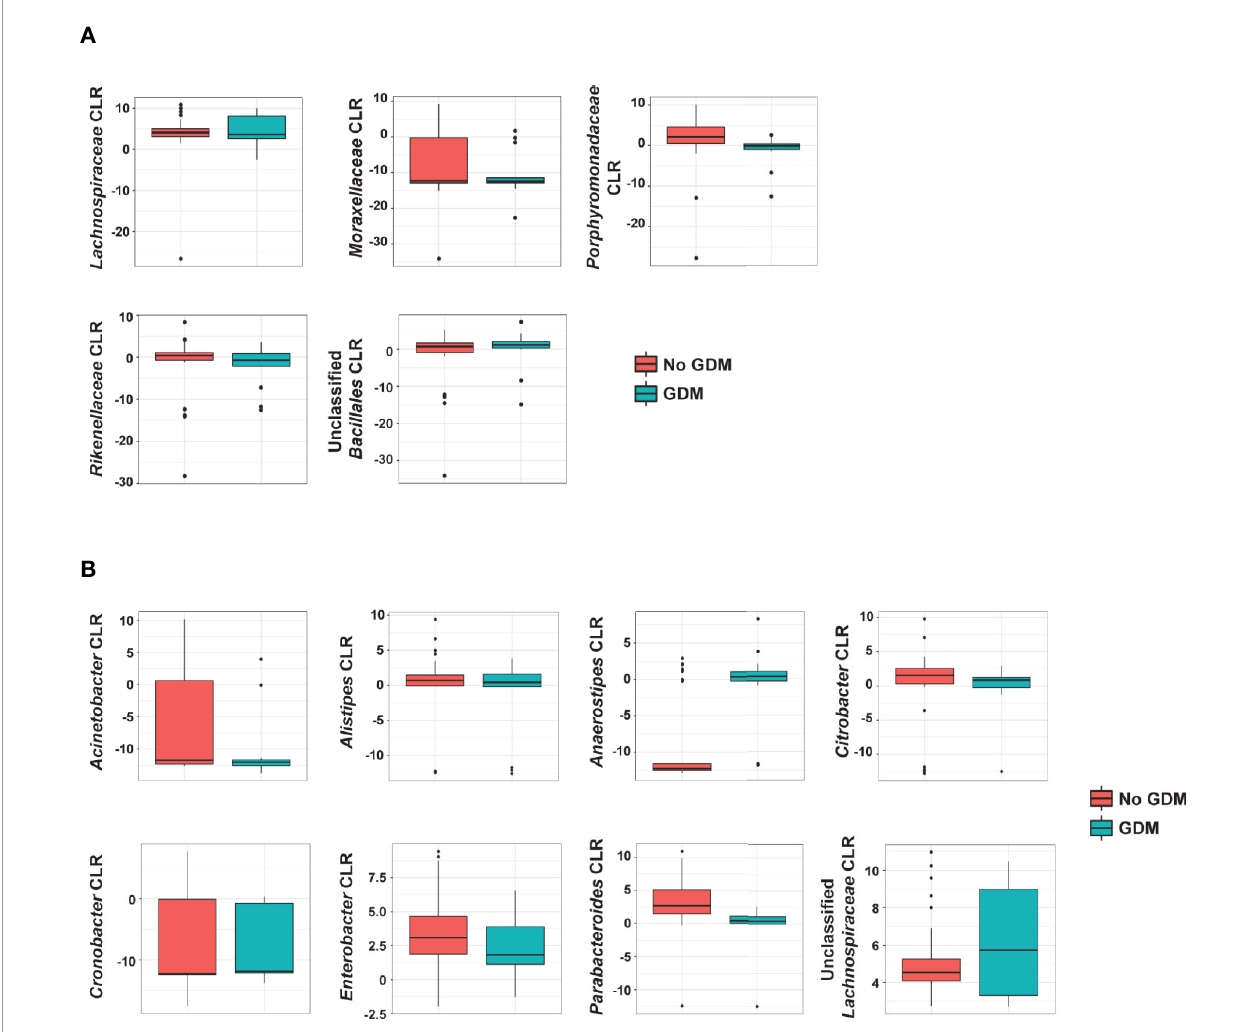
FIGURE 4 | Summary of the impact of maternal GDM on infant gut microbial taxa in the additive model. Box plots of centered log ratio (CLR) transformed (A) family- and (B) genus-level taxa counts by maternal GDM status. Taxa displayed are those whose abundance changed signi fi cantly in infants from mothers with GDM after controlling for maternal weight group. GDM, gestational